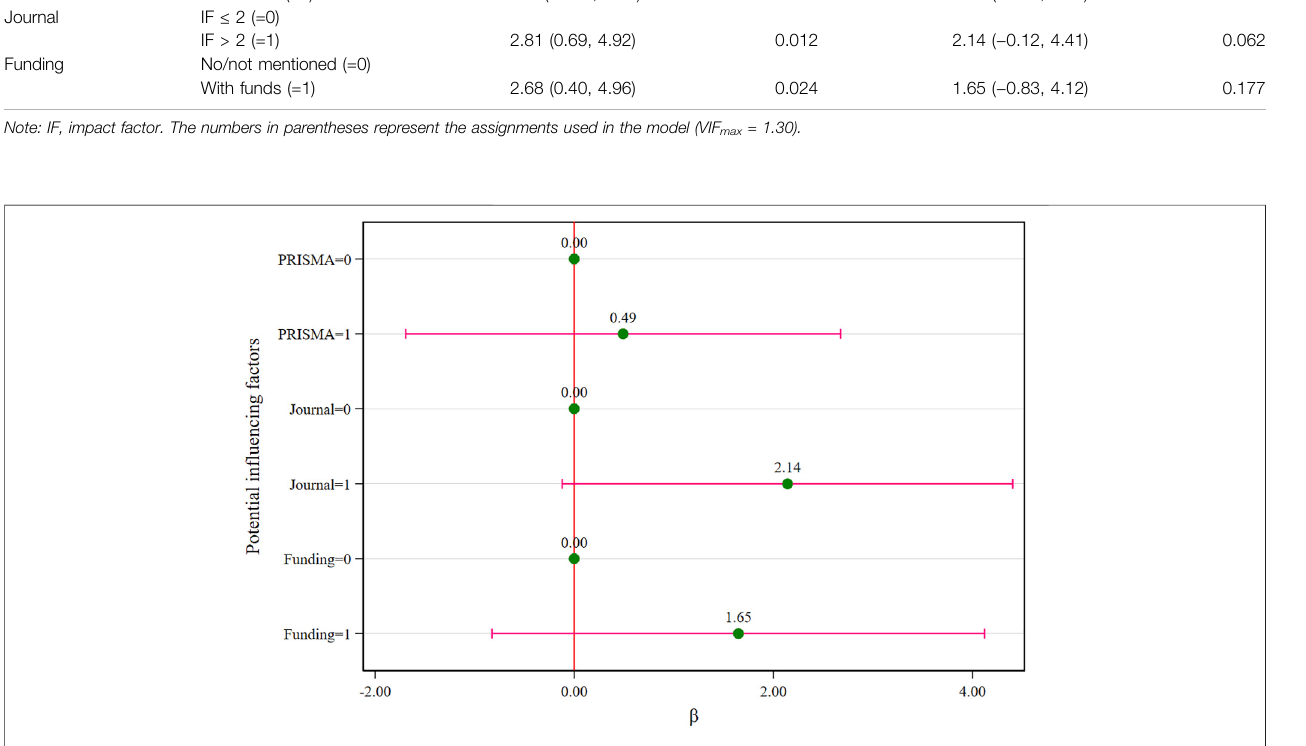
FIGURE 4 | Multivariate analysis of the methodological quality score (the assignments see Table 2